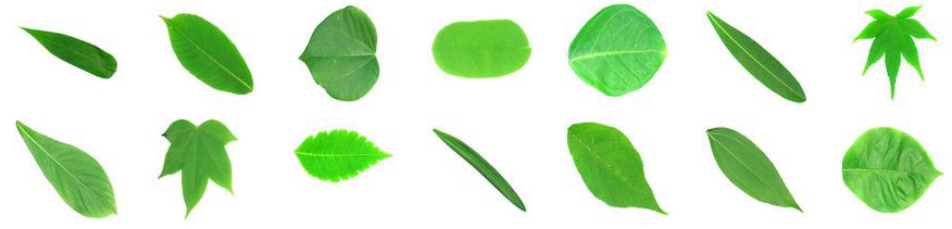
Figure 2. Some images of the F LAVIA dataset.